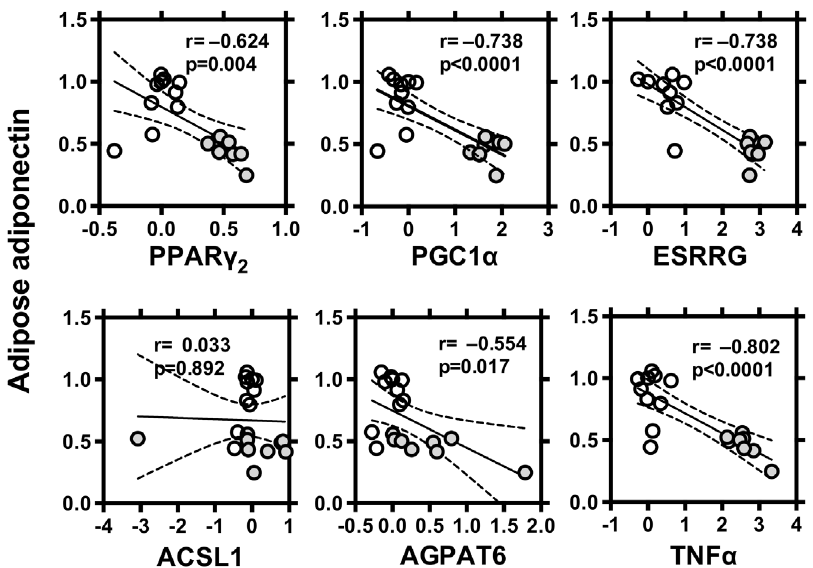
Figure 8. Correlation between level of adiponectin vs levels of PPAR c 2 , PGC1 a , ESRRG, ACSL1, AGPAT6 and TNF a in the adipose tissue of C57BL/6 and ob/ob mice. From normal C57BL/6 ( = , n=10) or diabetic ob/ob ( = , n=10) mice, epididymal adipose tissues were excised N and used for gene expression analyses. Expression levels normalized to those of b -actin were log-transformed. Linear regression analysis was made ) mice and, and r and p values are shown. on a combined group of C57BL/6 ( # ) and ob/ob (